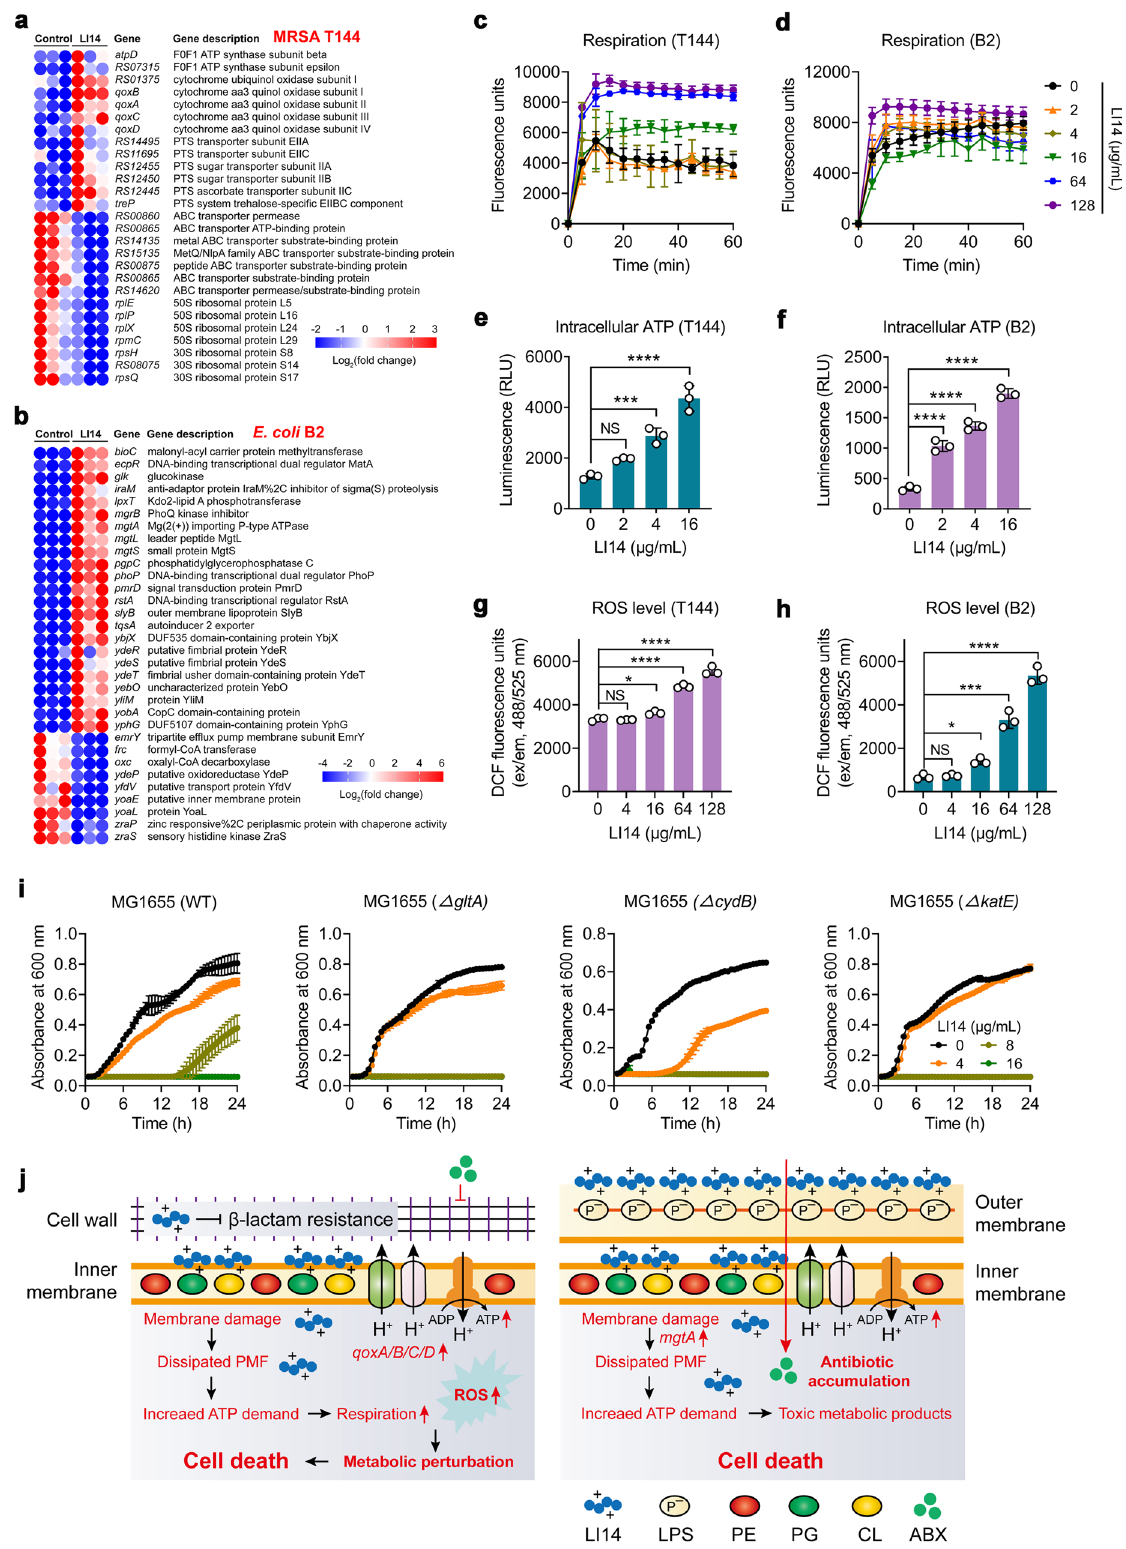
resistance (Supplementary Fig. 6). These results highlight the potency of LI14 as a novel broad-spectrum antibiotic synergist. Considering that the LI14 peptide exhibited potent antibacter- ial and synergistic activity in vitro, we next evaluated the in vivo ef fi cacy of LI14 alone or in combination with ampicillin/ rifampicin in various animal infection models. In the